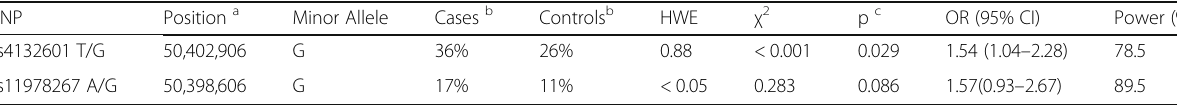
Table 2 Distribution of IKZF-1 variants alleles in ALL cases and controls SNP